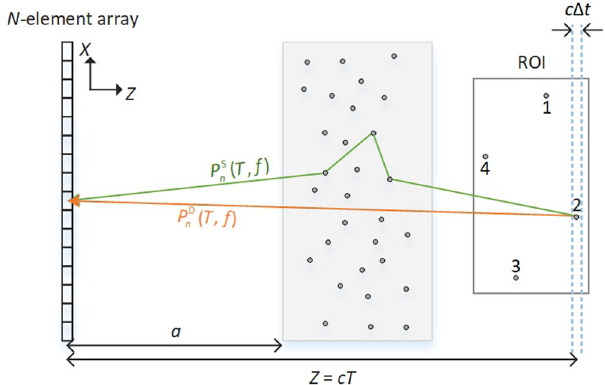
Figure 1. The schematic of the scenario to imaging through acoustic scattering layer. The signals are generated from the region of interest (ROI), propagate through the scattering layer (gray region), and are finally detected by the transducer array. The detected signals in the time window [ T − ∆ t /2, T − ∆ t /2] contain two components: P D ( T , f ) and P S ( T , f ), around the time of flight T and at the frequency f . P T f ( , ) emitted directly from the object located at a depth of Z = cT , while P T f ( , )